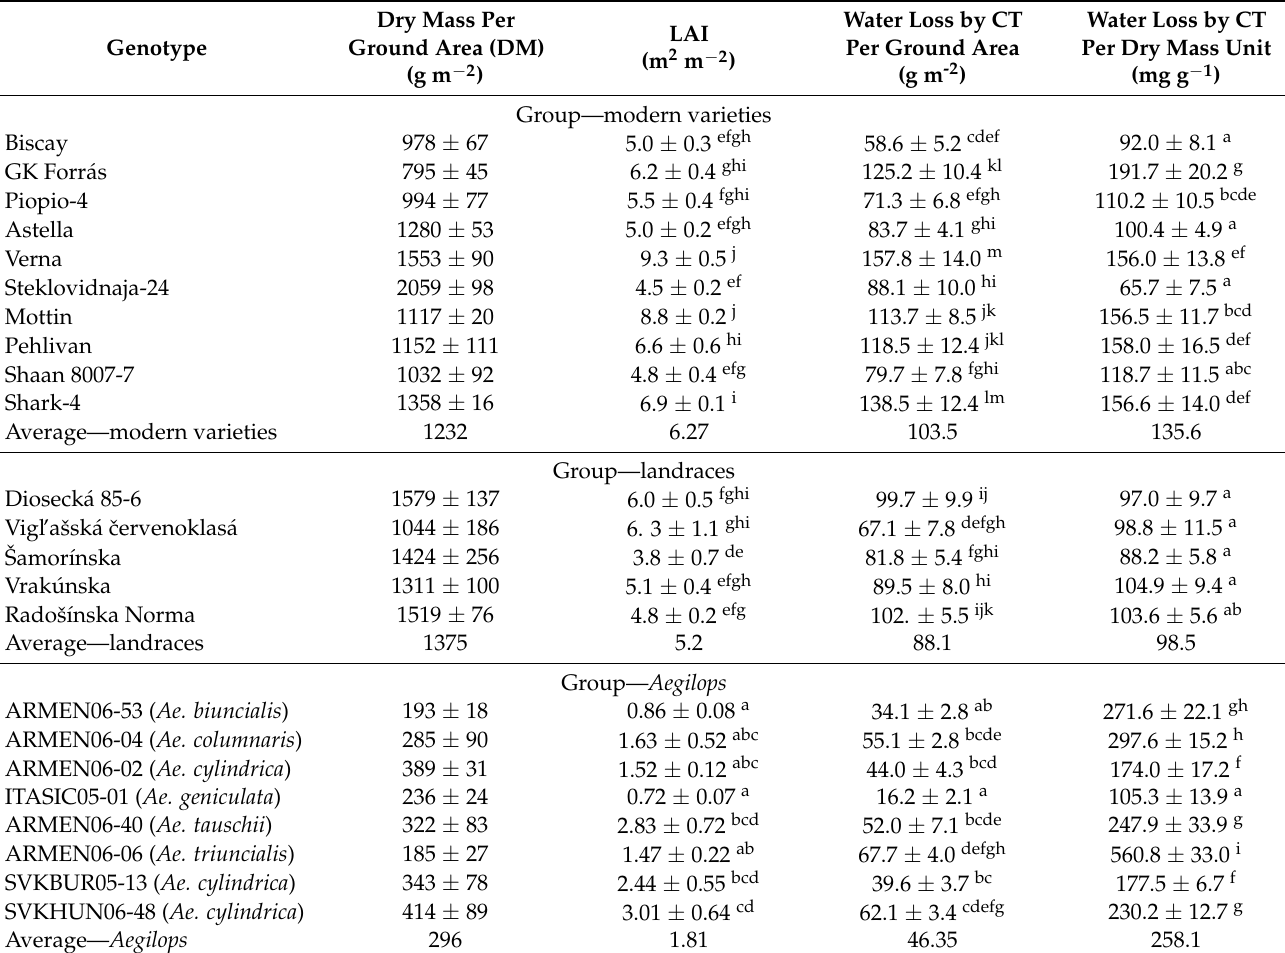
Table 2. Growth traits and estimates of water loss characteristics in three groups of Triticeae # .